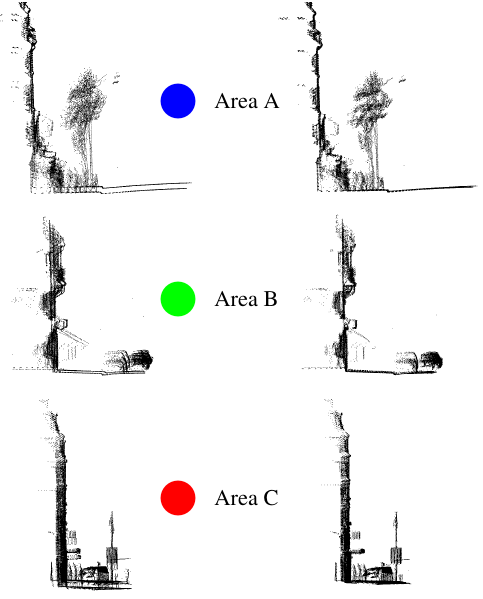
Figure 9: Results of our approach for three areas of interest. Left: before registration. Right: after